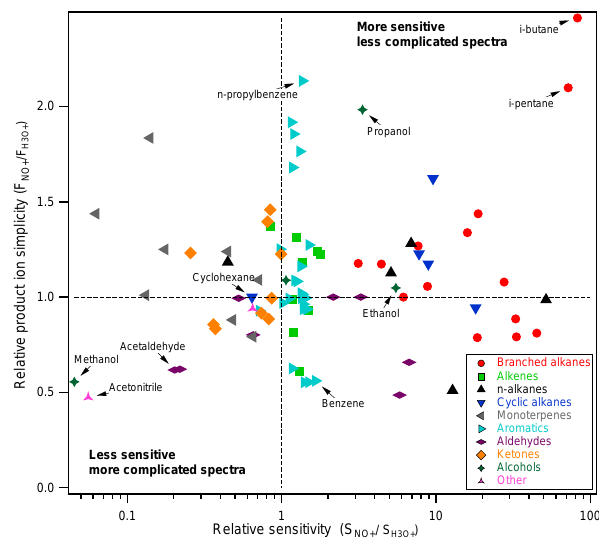
Figure 3. Comparison of production ion distribution and sensitivity of VOCs using NO + and H 3 O + reagent ion chemistry, at a relative humidity of 20%.